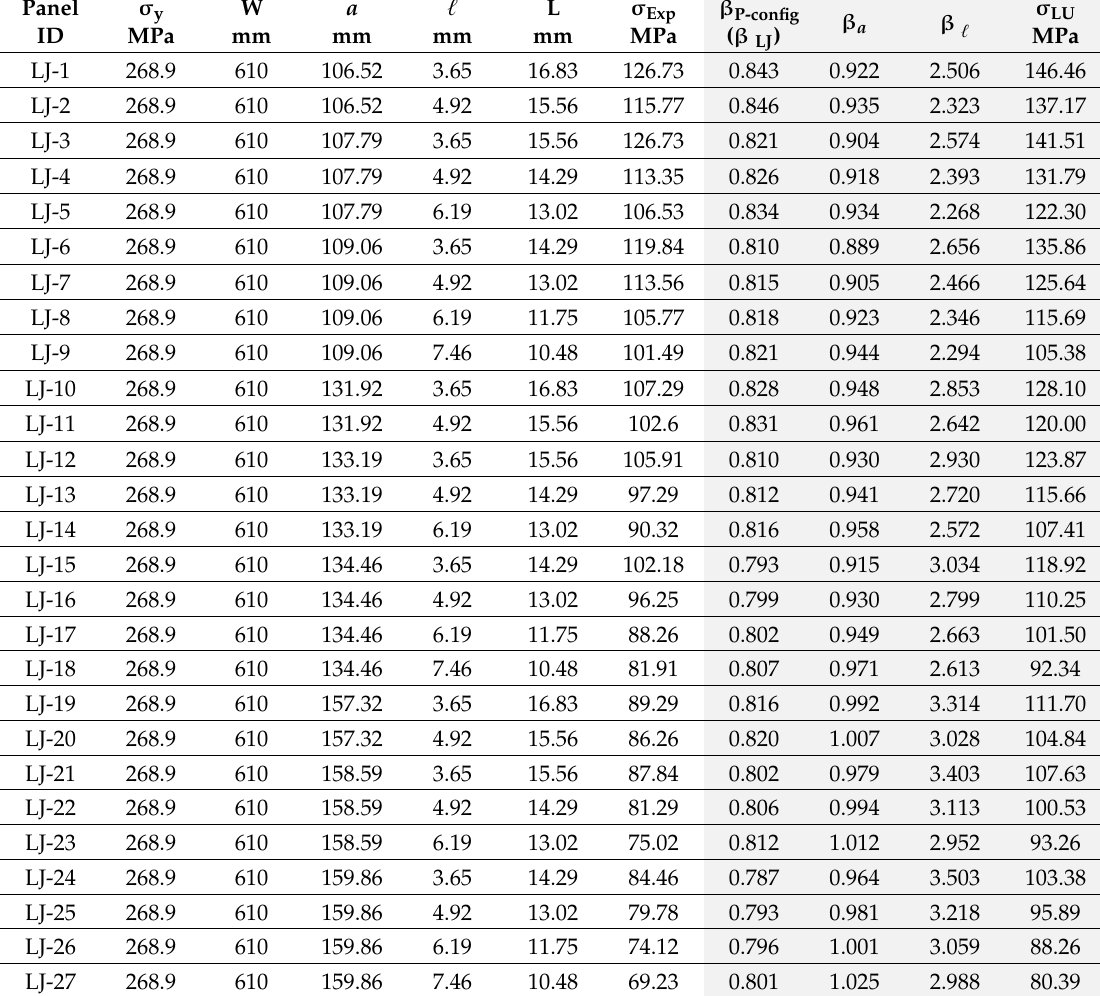
Table A3. Datasets for the lap-joint 2024-T3 panels (experimental data and calculated assistance parameters)